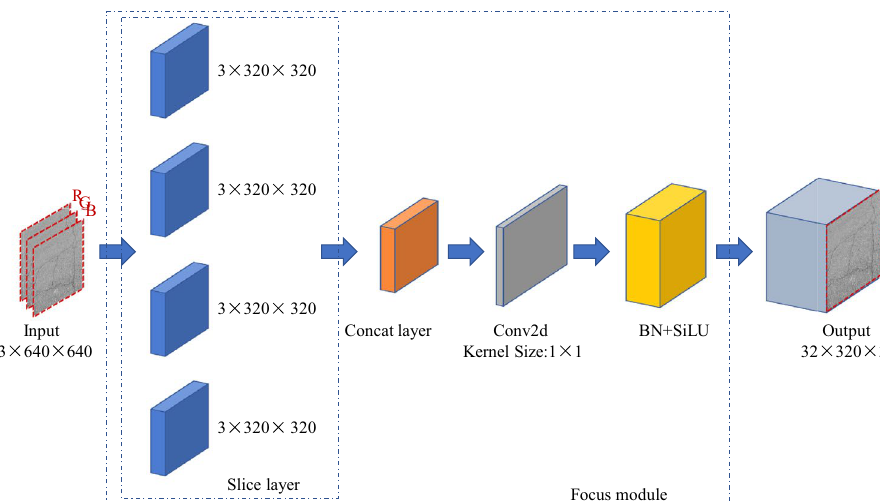
Figure 3. Structure of Focus module.